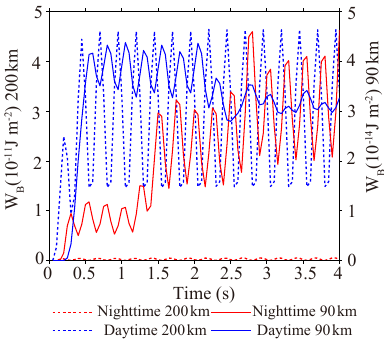
Figure 9. Temporal evolution of the magnetic energy of the artifi- cially generated ULF wave at the modulation frequency of 2.0Hz at a height of 90 and 200km in the daytime and nighttime ionosphere. Table 2. Ratio between the magnetic energy of the artificial ULF wave at 90 and 200km in the nighttime and daytime ionosphere at the modulation frequency of 2.0, 4.0 and 8.0Hz. Heating location Time (LT)